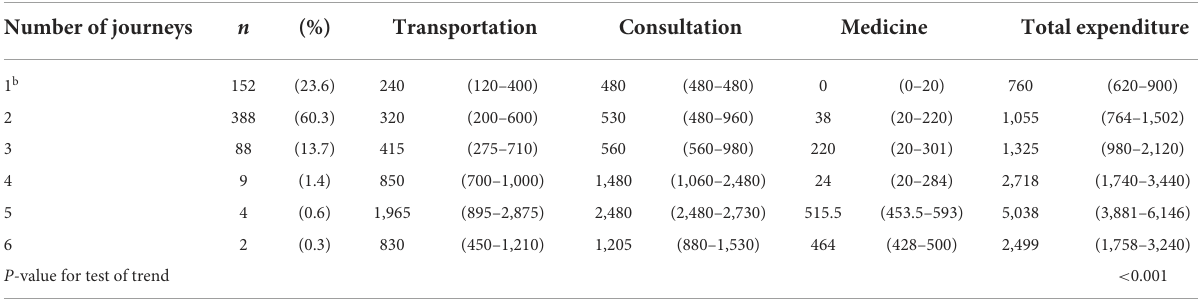
TABLE 4 Money spent by patients per number of facilities visited before coming to the eye hospital. Median cost of care (IQR) in Nepali Rupees a Number of